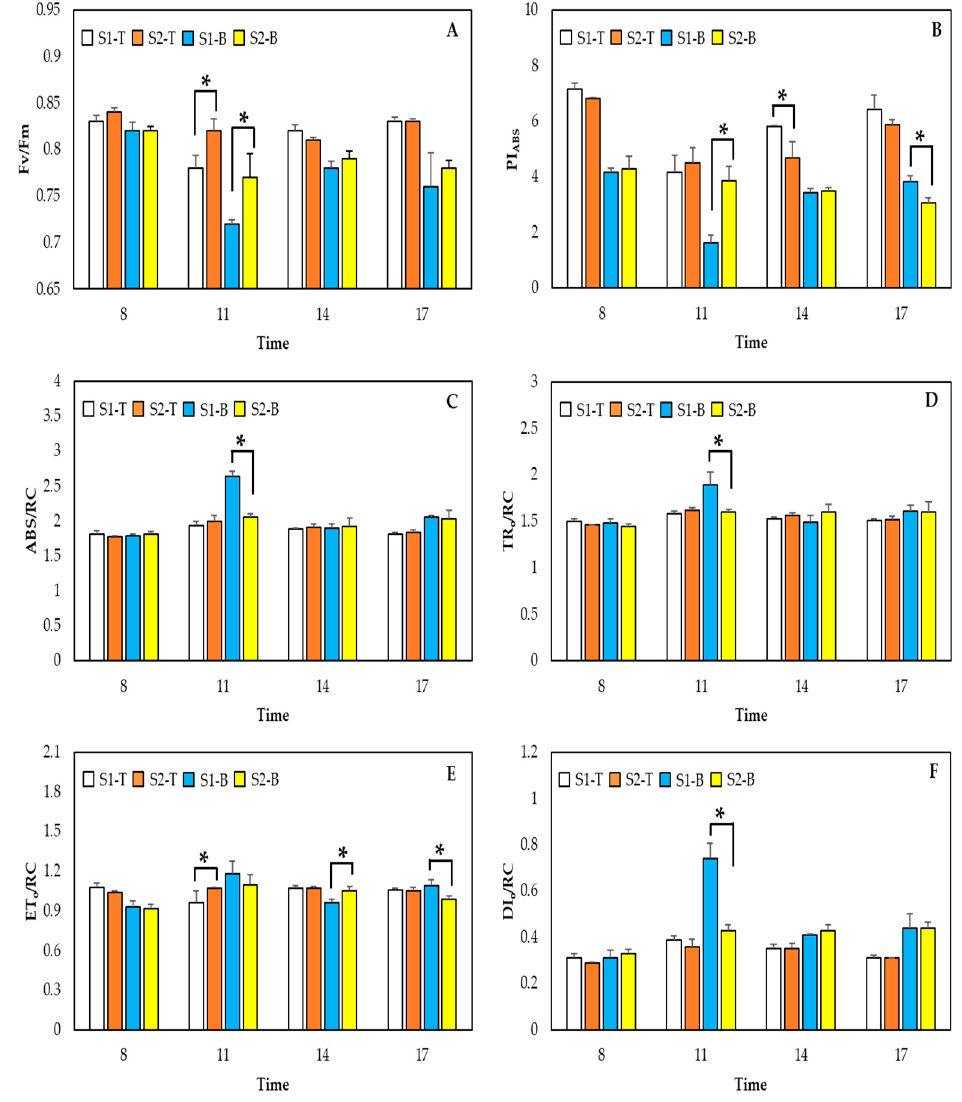
Figure 4. Effect of shade screen on Fv/Fm ( A ), PI ABS ( B ), ABS/RC ( C ), TR o /RC ( D ), ET o /RC ( E ) and DI o /RC ( F ) of paprika plant in greenhouse. S1 and S2 indicate plants were treated by single shade screen and double shade screens, respectively. T and B indicated top portions at 2 m height and bottom portions at 1 m height of the plant, respectively. Lines above bar represent the standard deviation of the mean ( n = 10). *, above the mean bars indicate significant difference between the treatments by Duncan’s multiple range test (DMRT) at p ≤ 0.05.